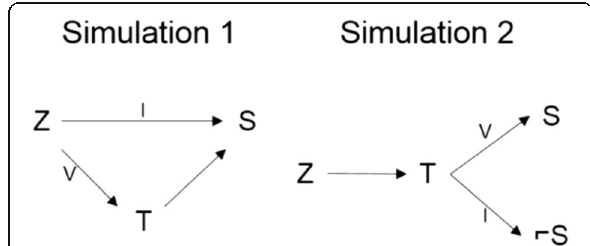
Fig. 4 Directed acyclic graphs outlining the scenarios mimicked in the two simulation studies